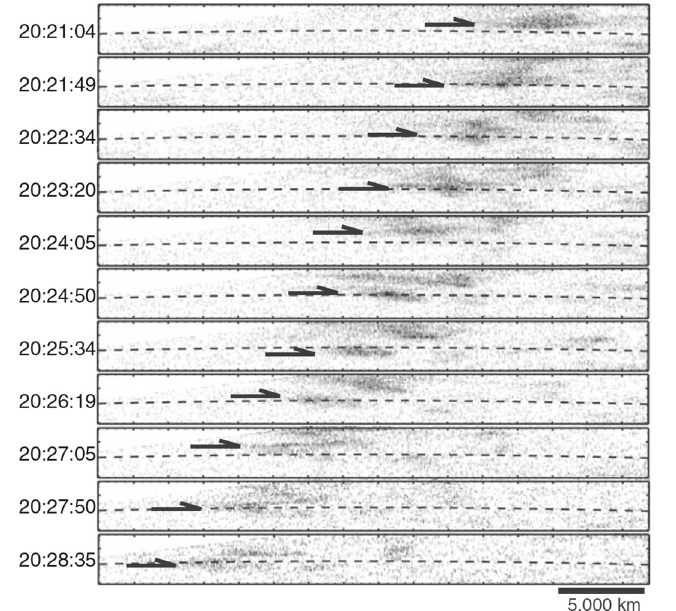
Fig. 30 Close-up view of a flowing thread displaying transverse oscillations. The measured flow speed is 39 km s − 1 , the amplitude of vertical oscillations is 900 km and the period is 174 s. Image reproduced with permission from Okamoto et al. (2007), copyright by